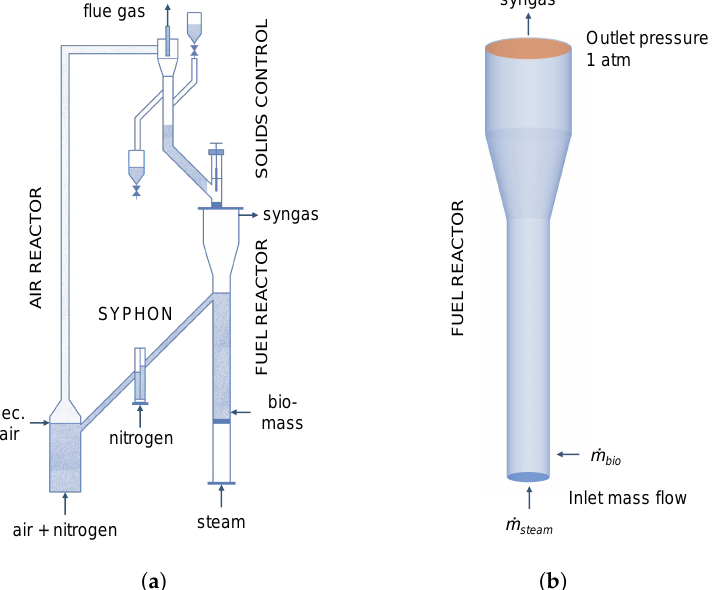
Figure 11. Schematic representation of the ( a ) experimental set-up adapted from Condori et al. [5] and ( b ) simulation geometry for the investigation of biomass gasification using ilmenite as oxygen carrier.